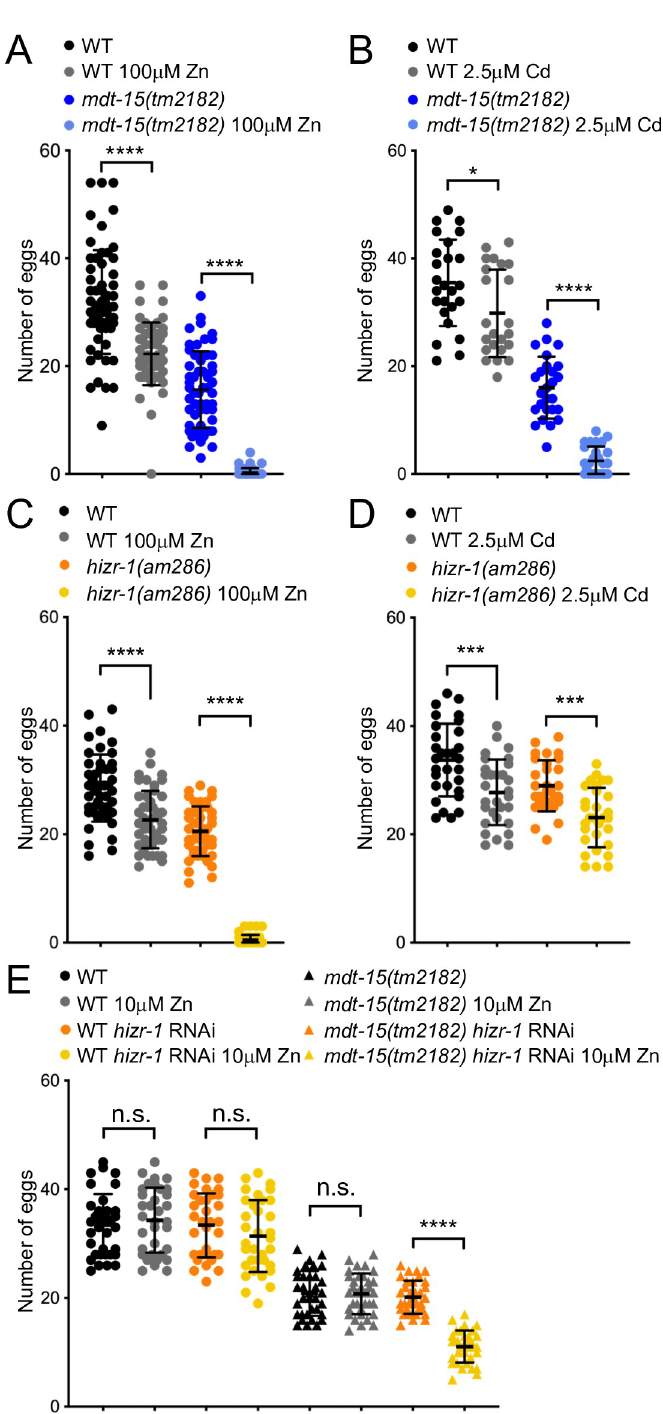
Fig 6. Loss of mdt-15 renders worms sensitive to cadmium and zinc. [A] The graph shows the average number of eggs laid over a 24-hour period by WT worms and mdt-15(tm2182) mutants grown on 0 μ M and 100 μ M zinc (Zn). Each dot represents progeny from an individual worm (WT 0 μ M Zn: n = 59; WT 100 μ M Zn: n = 56; mdt-15(tm2182) 0 μ M Zn; n = 57; mdt-15(tm2182) Zn: n = 51; from 3 independent repeats). Error bars: standard deviation; statistical analysis: ���� p < 0.0001, Two-way ANOVA, multiple comparisons; Tukey correction. [B] The graph shows the average number of eggs laid over a 24-hour period by WT worms and mdt-15(tm2182) mutants grown on 0 μ M and 2.5 μ M cadmium (Cd). Each dot represents progeny from an individual worm (WT 0 μ M Cd: n = 25; WT 2.5 μ M Cd: n = 23; mdt-15(tm2182) 0 μ M Cd: n = 26; mdt-15(tm2182) on 2.5 μ M Cd: n = 27; from 3 independent repeats).